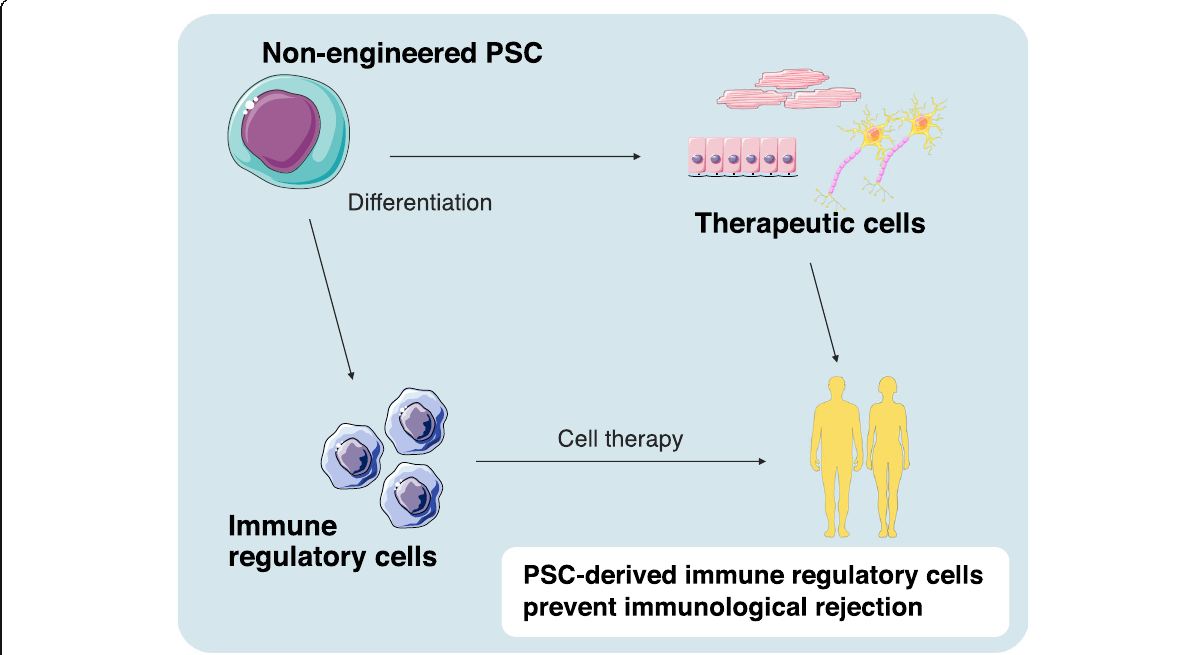
Fig. 2 Immunoregulatory cell induction from pluripotent stem cells. Immunoregulatory cell differentiation and combined cell therapy to prevent immunological rejection against PSC-derived therapeutic